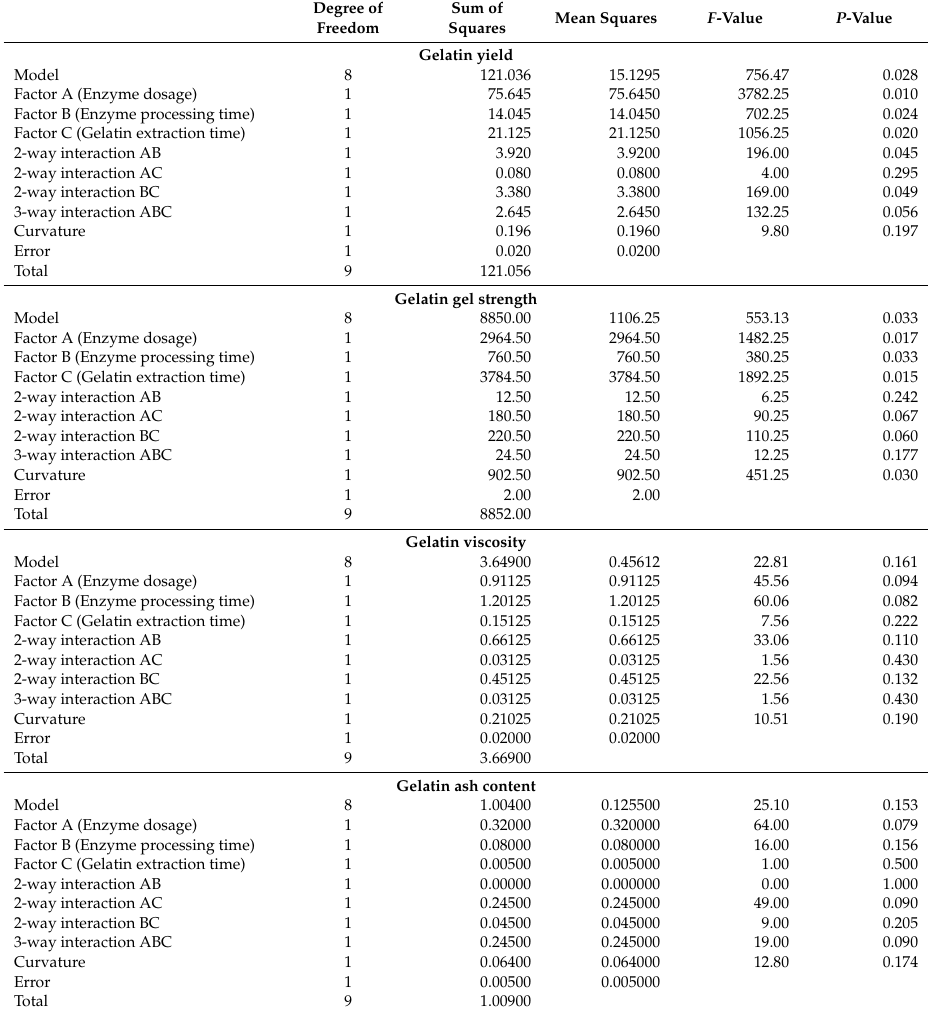
Table 3. Analysis of variance of the experimental design for gelatin yield, gelatin gel strength, gelatin viscosity and gelatin ash